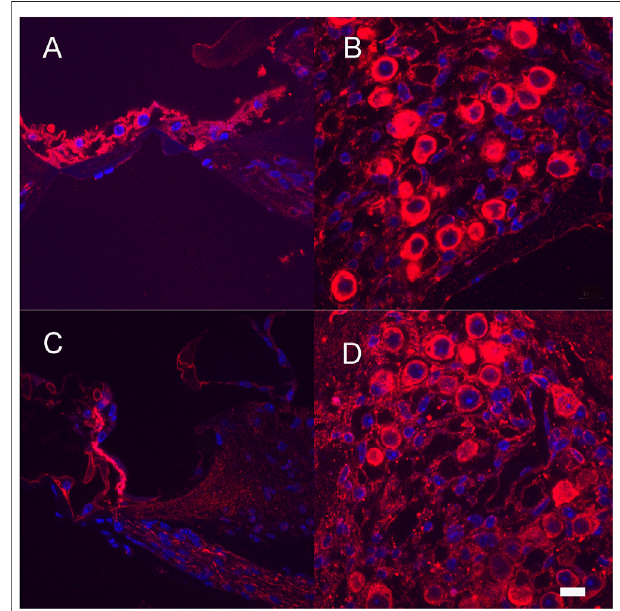
FIGURE 5 | Neuronal survival after low-level neurotrophin gene therapy using the lat promoter (A) . Section through Rosenthal ’ s canal in the basal turn of an adult hearing mouse shows spiral ganglion neurons immunostained for neuro fi lament (red). Cell nuclei are stained in blue using DAPI injection of neomycin into the round window that resulted in loss of greater than 50% of spiral ganglion cells (B) Example of missing neurons are shown with arrow (B) Neomycin treatment followed by delivery of Ad28.lat.bdnf into the posterior semicircular canal resulted in improved survival of spiral ganglion cells (C) . Animals treated with Ad28.lat.ntf3 after neomycin treatment resulted in optimal neuronal survival and morphology similar to controls (D) . Scale bar = 10 µm.